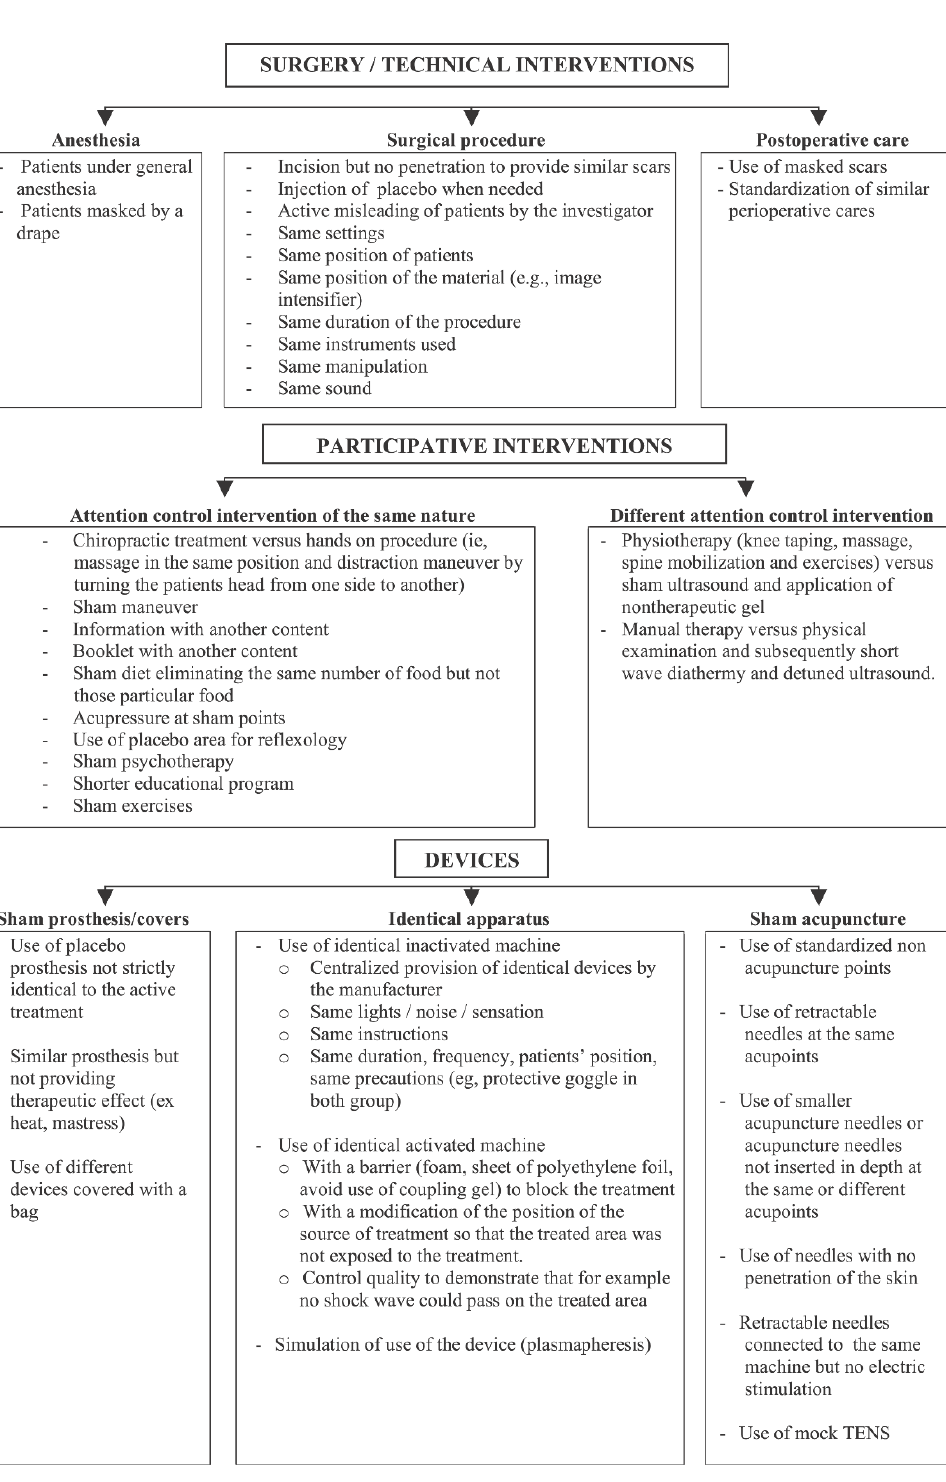
Figure 2. Methods of blinding participants, health care providers, or other caregivers that rely on the category of treatment and comparator assessed. Reprinted with permission from ref. [43]. Copyright 2007 Boutron et al. Full text available from https://journals.plos.org/plosmedicine/arti- cle?id=10.1371/journal.pmed.0040061#s5.